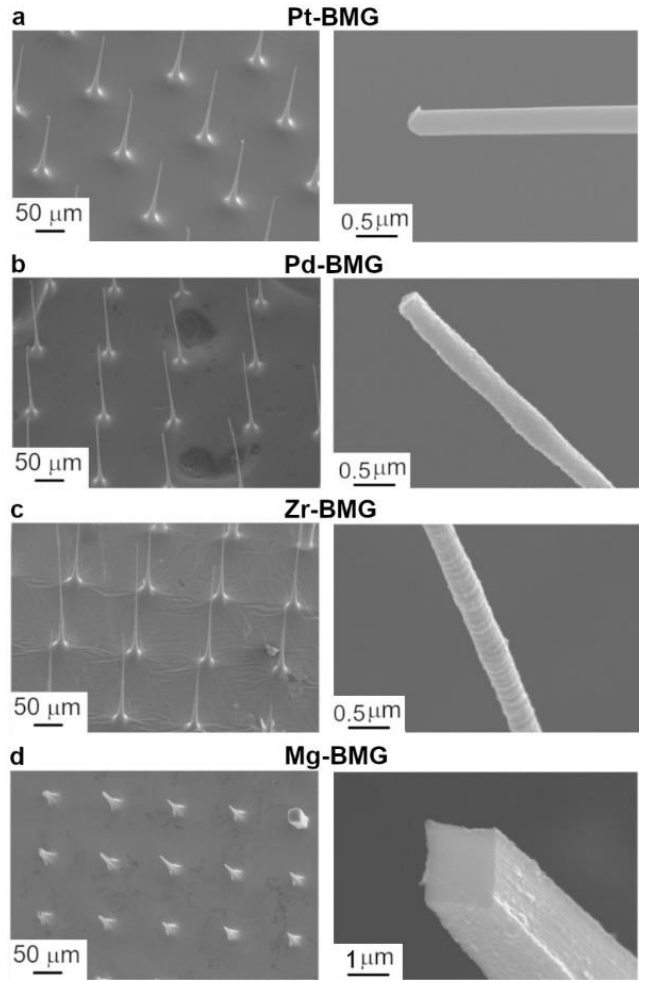
Figure 11. Examples of thermoplastically drawn structures from inert and oxidizing BMGs. ( a ) Pt-BMG, ( b ) Pd-BMG, ( c ) Zr-BMG and ( d ) Mg-BMG. The surface roughness due to oxide layer is visible in the oxidizing BMGs.